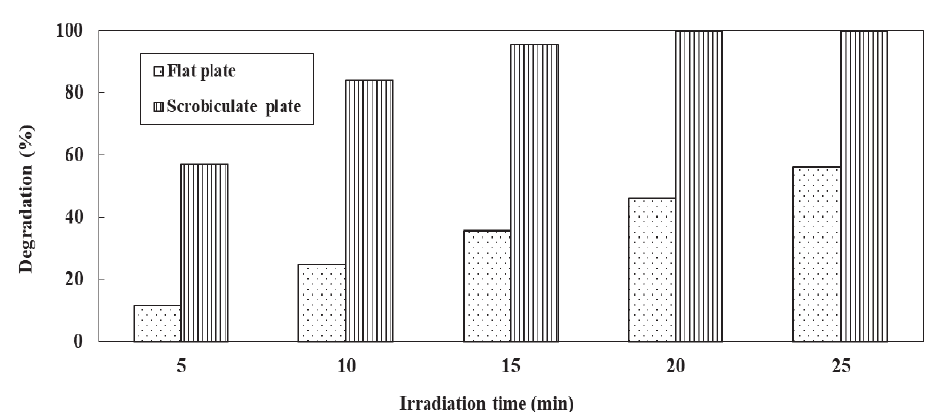
Fig. 3 – Effect of the type of the spinning disc on the removal percent of PNP in the SDP. [PNP] = 20 mg L –1 , volume = 500 mL, pH = 5.5, [H O ] = 1500 mg L –1 , rotation speed = 300 rpm, light intensity = 33 W m –2 , distance between lamps = 3.5 2 2